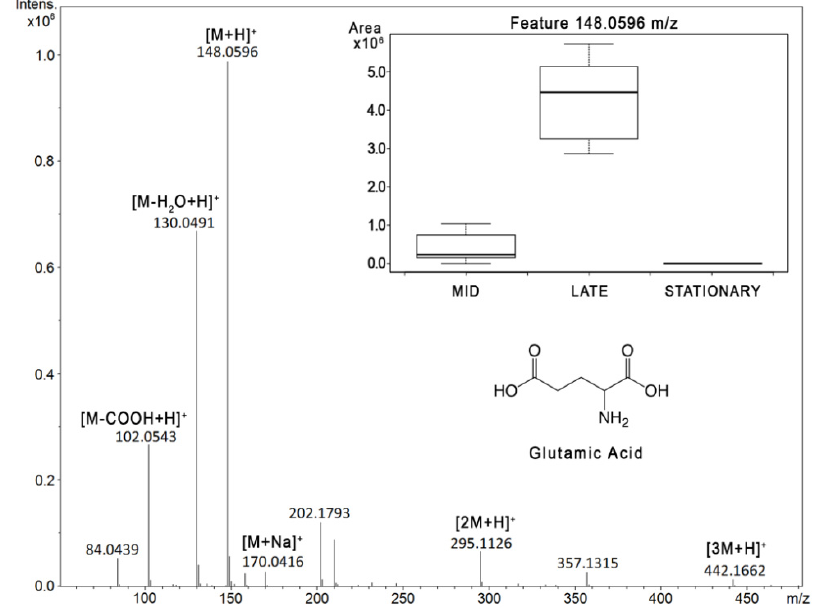
Figure 3. Mass spectrum taken from late stationary phase sample L5, depicting the metabolite feature eluting at 1.9 min correlating to glutamic acid and [M + H] + at 148.0596 m / z . Identified in the spectrum are the loss of carboxylic acid [M-COOH + H] + , the loss of water [M-H 2 O + H] + , the sodium adduct [M + Na] + , the dimer [2M + H] + , and the trimer [3M + H] + . The inset graph shows the production and decline of the feature identified as glutamic acid for mid, late, and stationary phases, with box and whisker plots from the five biological replicates.